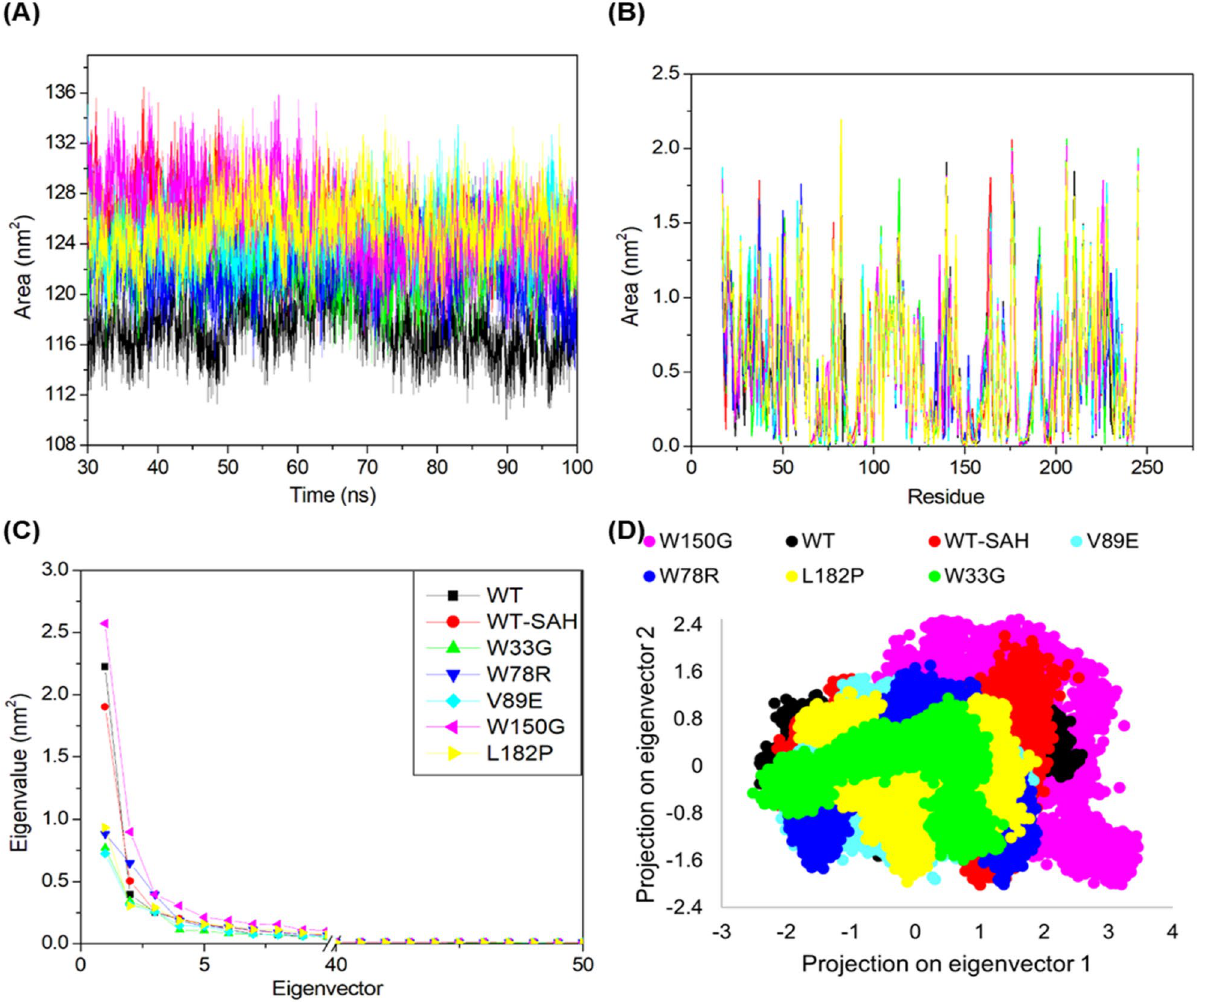
Figure 4. SASA analysis and PCA